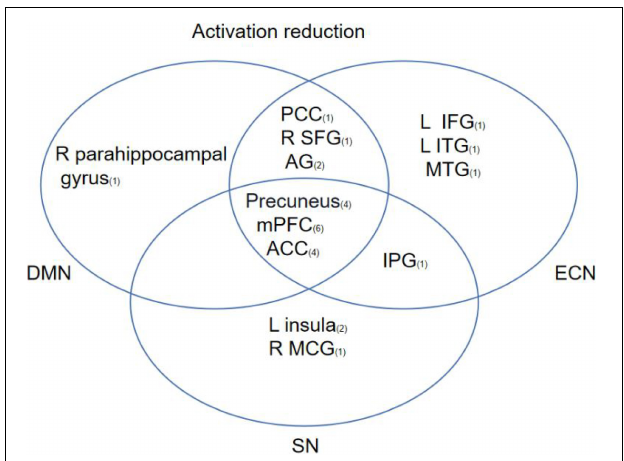
FIGURE 4 | This figure shows regions that have been reported to show CBT-related changes and the overlap between regions involved in different brain networks. The subscript number next to the brain region represents the number of articles related to that brain